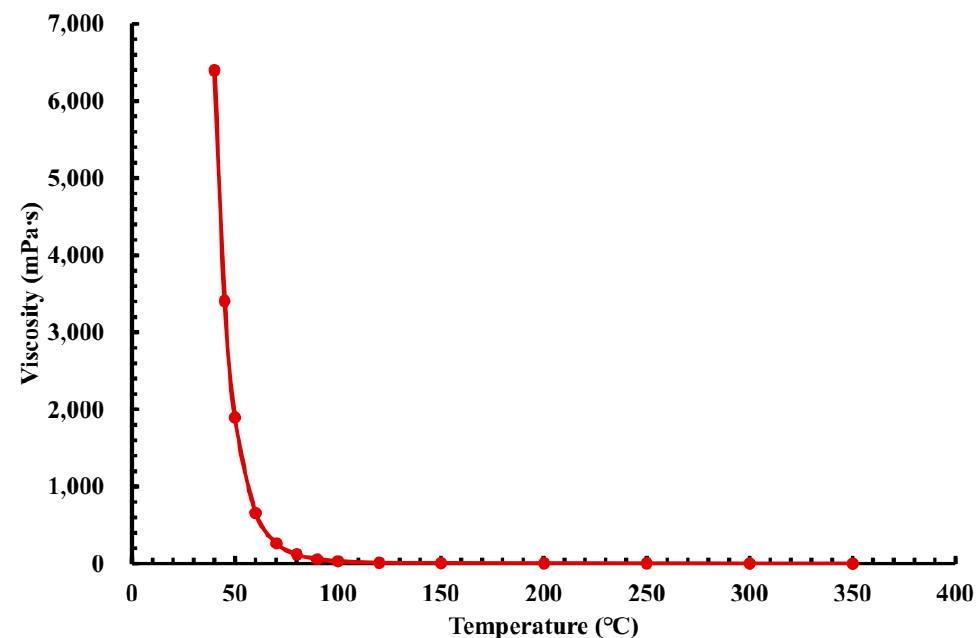
Figure 10. The viscosity-temperature curve of a higher oil